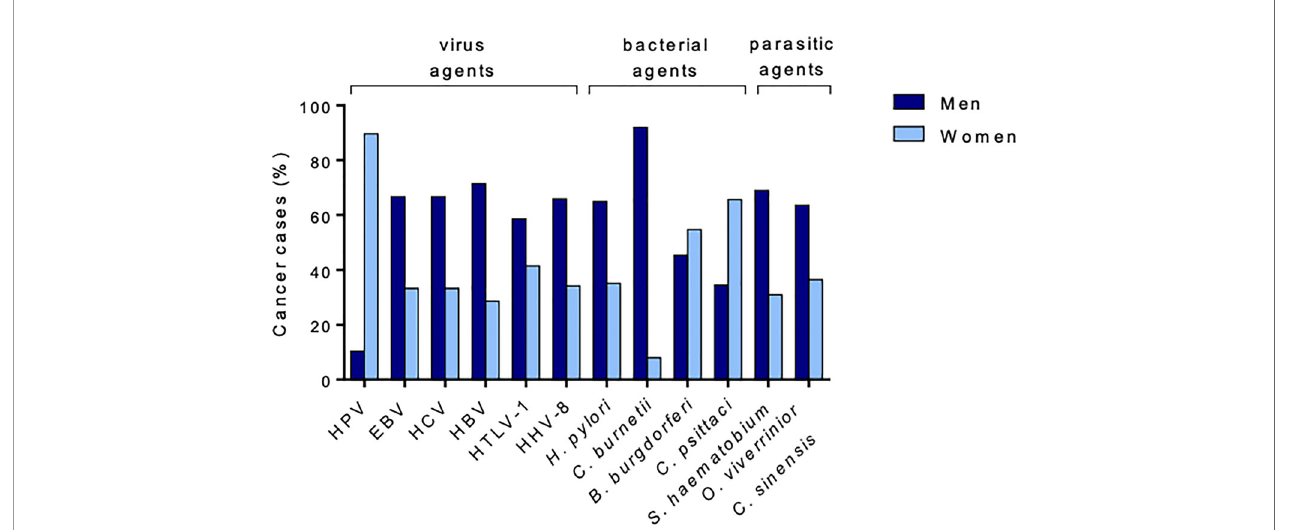
FIGURE 7 | Percentage of cancer cases attributable to infectious agents by sex. Sex disparities are observed in infection-associated cancers. Globally, men are more likely to develop cancer because of infection, except in a few cases, such as HPV